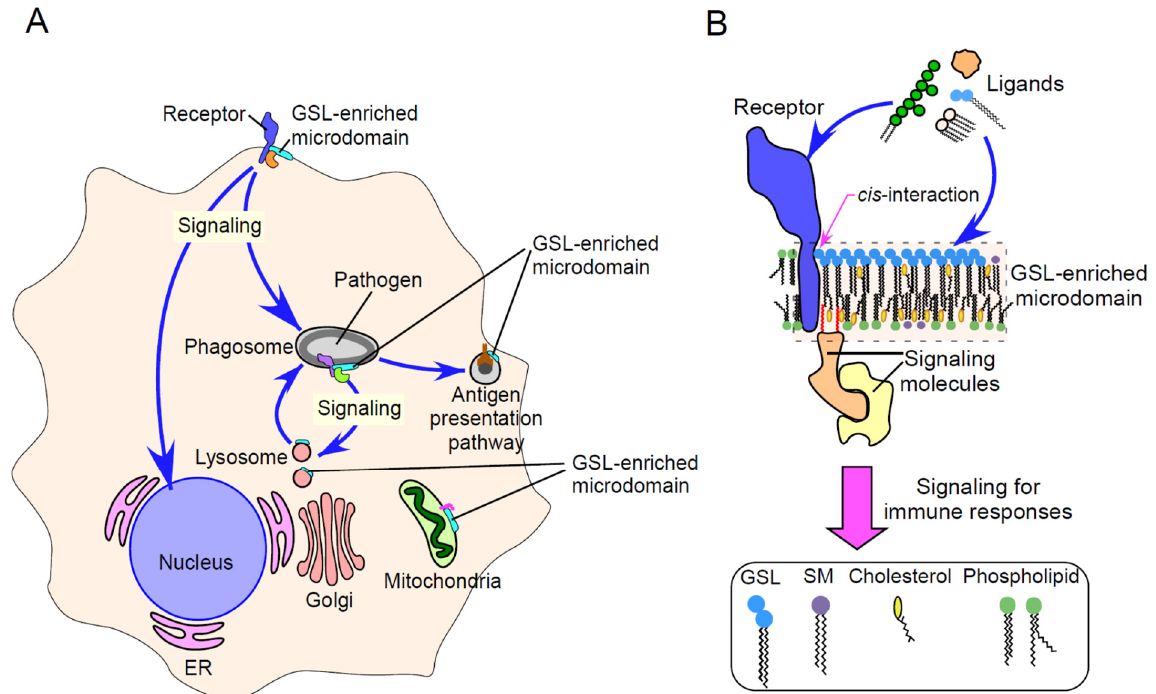
Figure 2. Multiplicity of GSL-enriched microdomain-driven immune signaling. ( A ) Schematic image showing multiplicity of GSL-enriched microdomain-driven signaling in immune cells. In both innate and adaptive immunity, GSL-enriched microdomains affect immune signaling by themselves or by cis- interaction with various immune receptors. This results in various immune responses, such as cytokine production, phagocytosis/phagosome maturation, antigen presentation and apoptosis. GSL-enriched microdomains are present not only in plasma membranes but also in membranes of intracellular organelles, such as lysosomes and phagosomes. LacCer forms membrane microdomains on intracellular granules, including lysosomes, in human neutrophils, and these LacCer-enriched microdomains on phagosomes act as a platform of intracellular signaling required for phagosome maturation (fusion of lysosomes to pathogen-containing phagosomes). GD3 forms membrane microdomains on mitochondria-associated membranes (MAMs) and contributes to autophagosome assembly. ER, endoplasmic reticulum. Golgi, Golgi apparatus. ( B ) Schematic image showing cis -interactions between GSL-enriched microdomains and immune receptors. The transfer of signals induced by ligand binding into cells involves the direct binding of these ligands to GSL-enriched microdomains in plasma membranes, followed by the transduction of the signals through membrane-associated signal transduction molecules. In addition, signaling molecule-associated GSL-enriched microdomains interact in cis with various receptor proteins, leading to a variety of immune responses. Thus, GSL-enriched microdomains provide signaling platforms for ligand binding to the plasma membranes of immune cells. Intracellular GSL- enriched microdomains may provide platforms for cross-talk among several types of proteins, such as membrane-associated and signaling proteins and sphingolipid